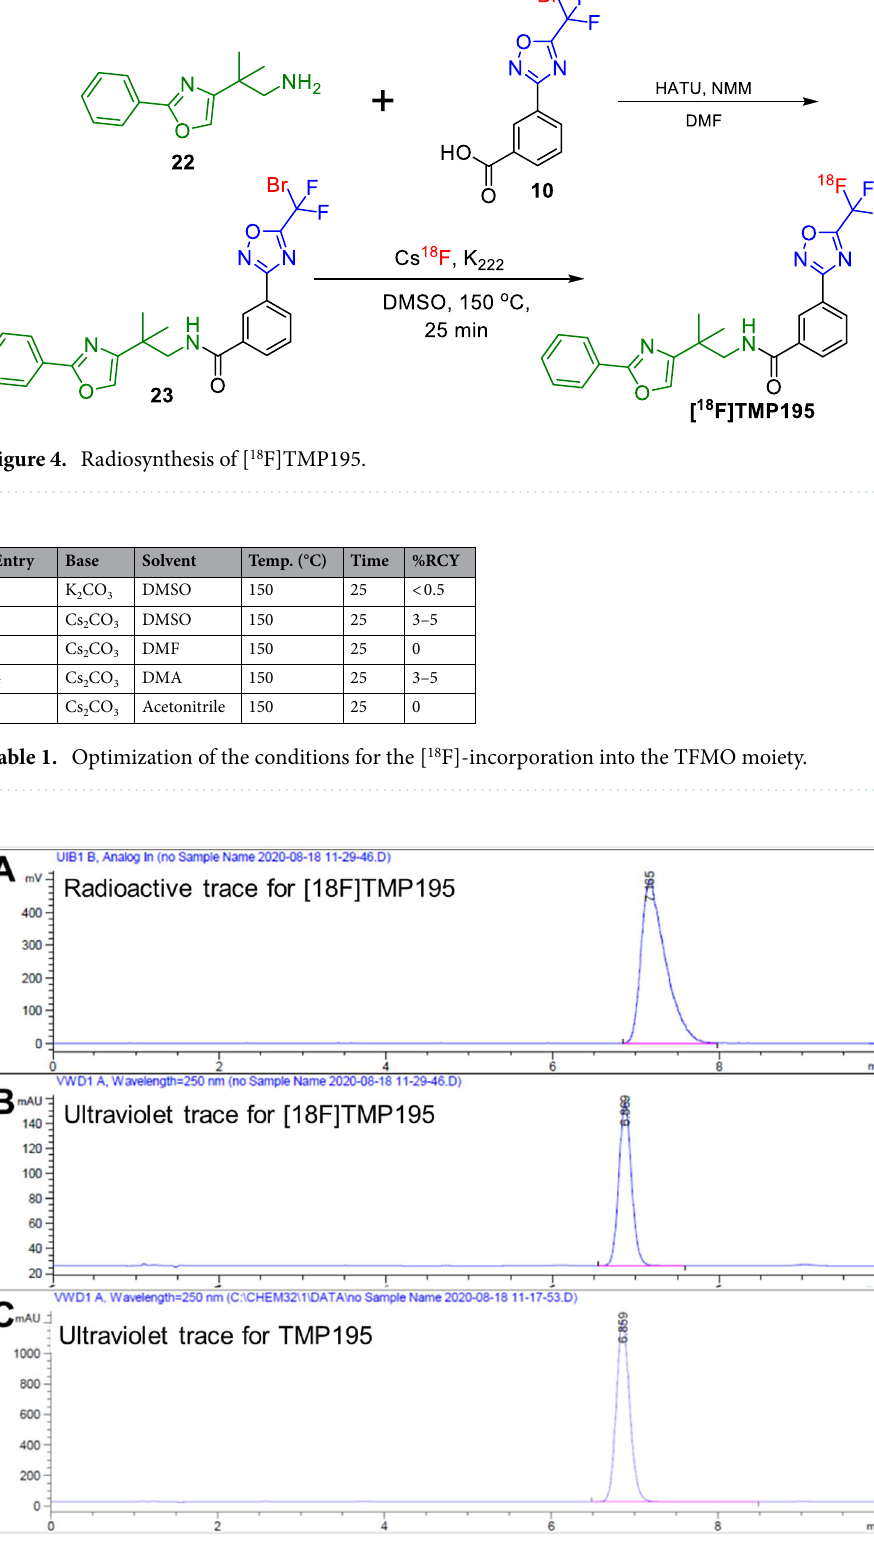
Figure 5. High performance liquid chromatography (HPLC) chromatograms ( a ) radioactive peak of [ 18 F] TMP195 detected with radioactivity detector, ( b ) [ 18 F]TMP195 associated cold mass was detected with ultraviolet detector and ( c ) TMP195 detected with ultraviolet detector. [ 18 F]TMP195 peaks detected by both ultraviolet (250 nm) and radioactive traces were consistent with TMP195 ultraviolet peak, thus confirming the identity of the target